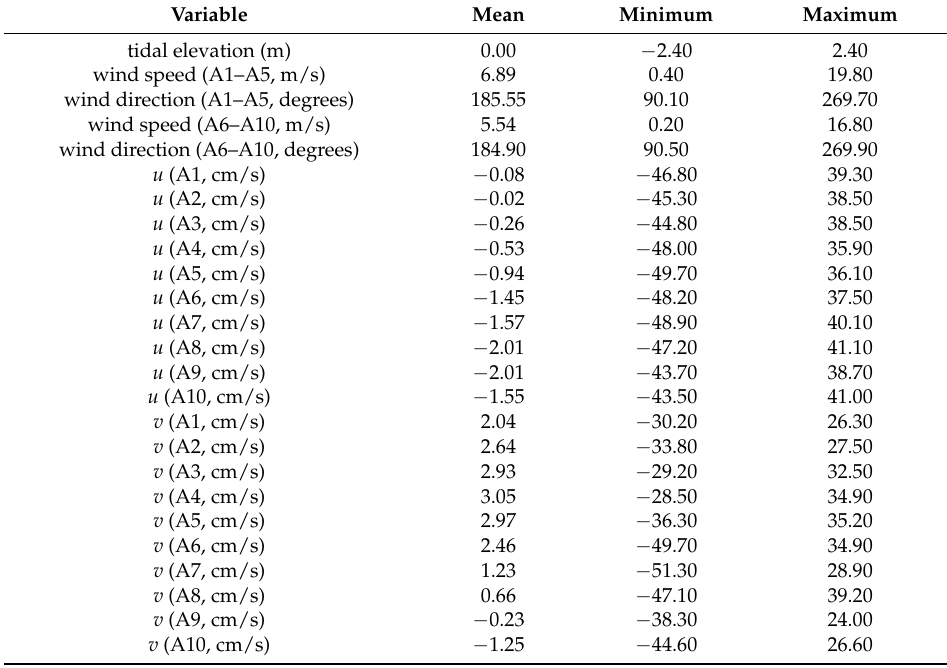
Table 1. Mean and range of training dataset (60% of full